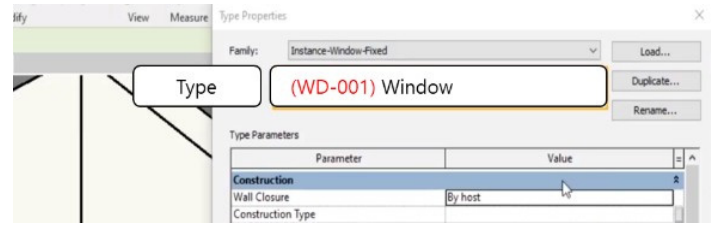
Figure 4. Method to input check code in the BIM model.